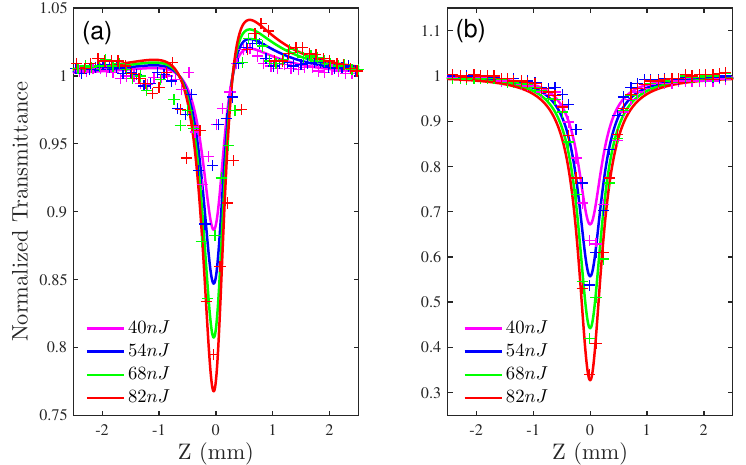
Figure 1. The experimental (dots) and fitting (solid lines) results of the Z-scan measurements for the 9 µ m-thick- c -Si sample at 800 nm, using incident fluence of 40 (magenta), 54 (blue), 68 (green) and 82 nJ (red), respectively. ( a ) Closed aperture Z-scan (normalised transmittance with a 500- µ m aperture). ( b ) Open aperture Z-scan (normalised transmittance without aperture).